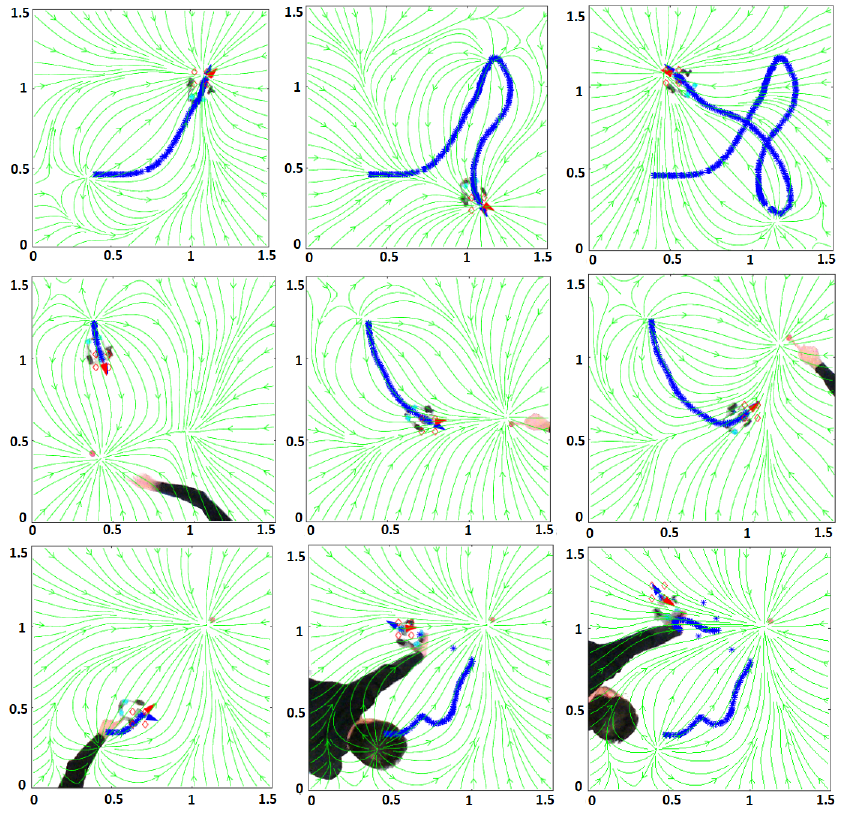
Figure 6. Experimental tests with a LEGO robot. Rows 1, 2, 3 for tests 1A, 2A, 3A.